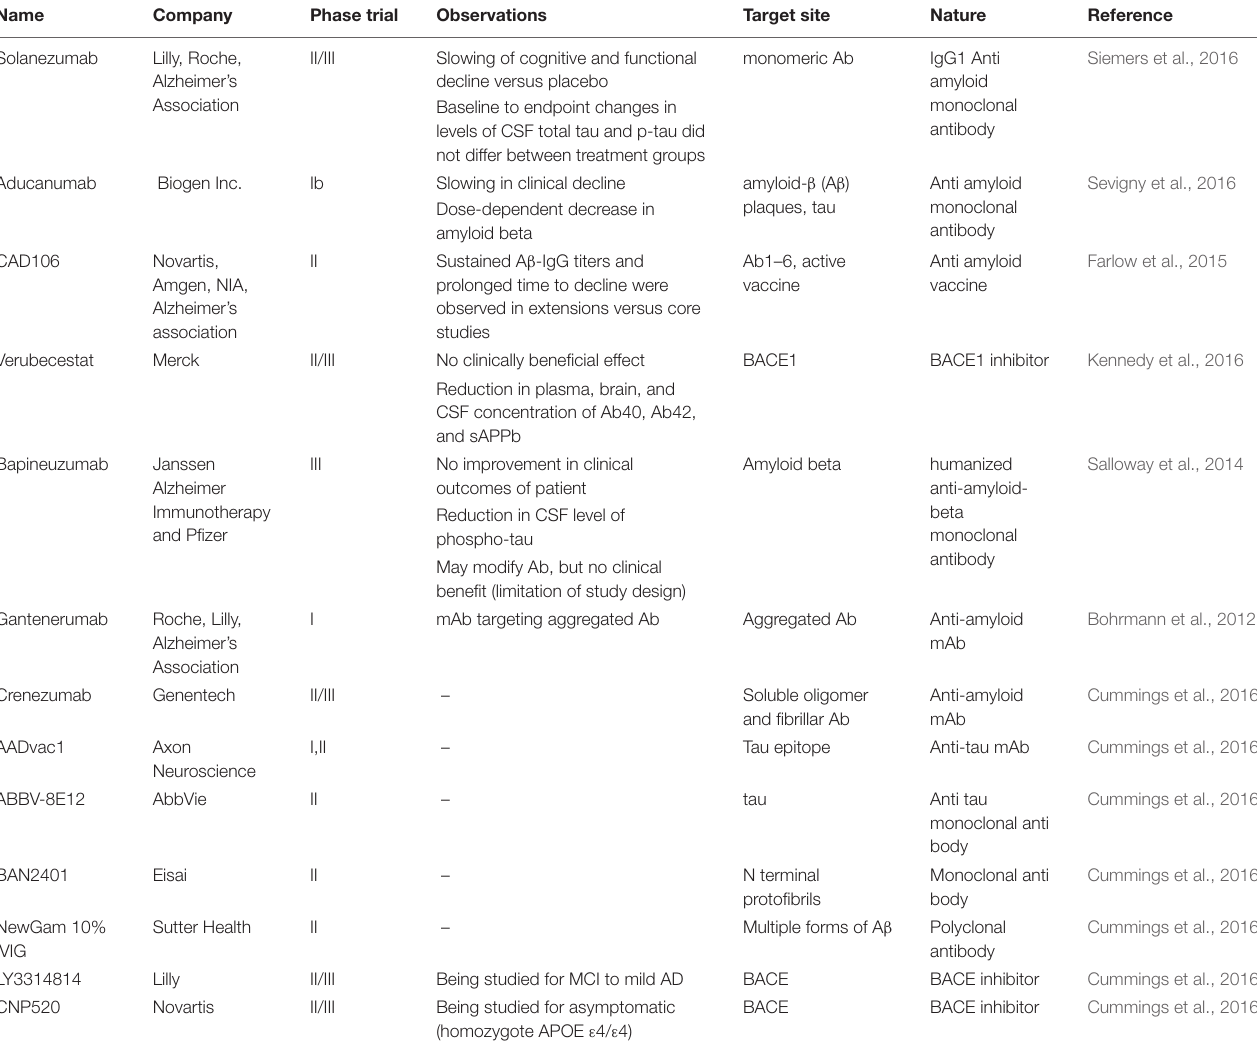
TABLE 4 | Properties of some important antibodies and BACE inhibitors at different phases of